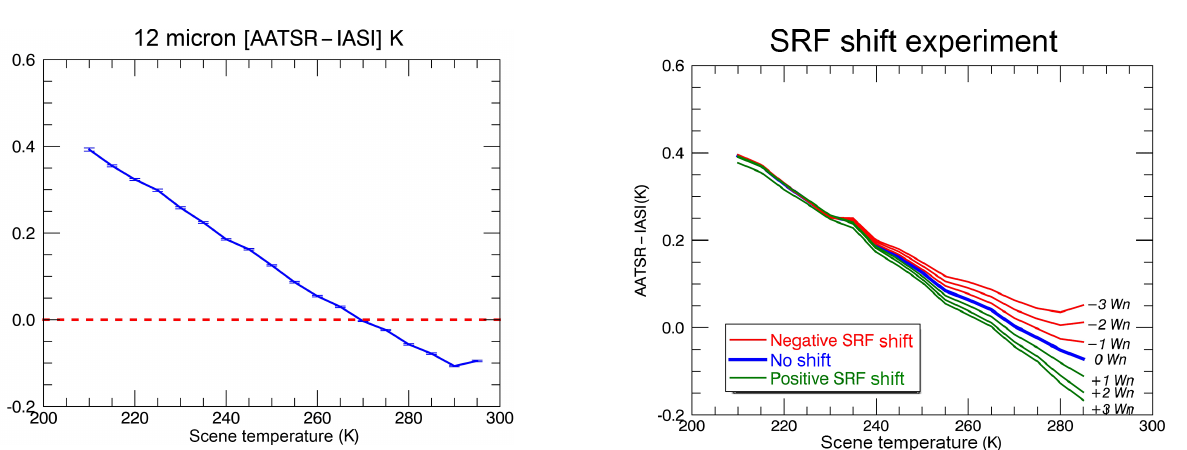
Figure 5. Impact of shifting the AATSR spectral response function by three wave numbers on either side of its central wave number (Wn) position in steps of 1Wn. The scene-temperature-dependent nature of AATSR-IASI-A bias does not diminish by shifting SRF.